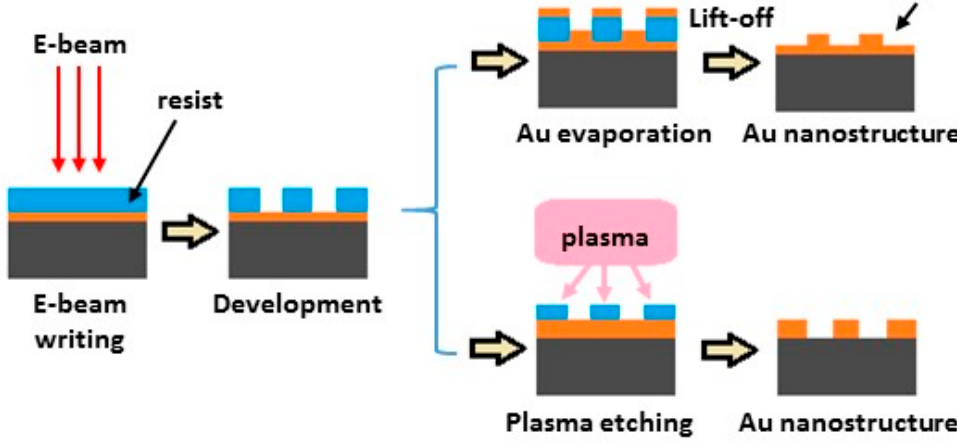
Figure 10. Schematic of the two fabrication processes used to prepare nanostructured SERS substrates.